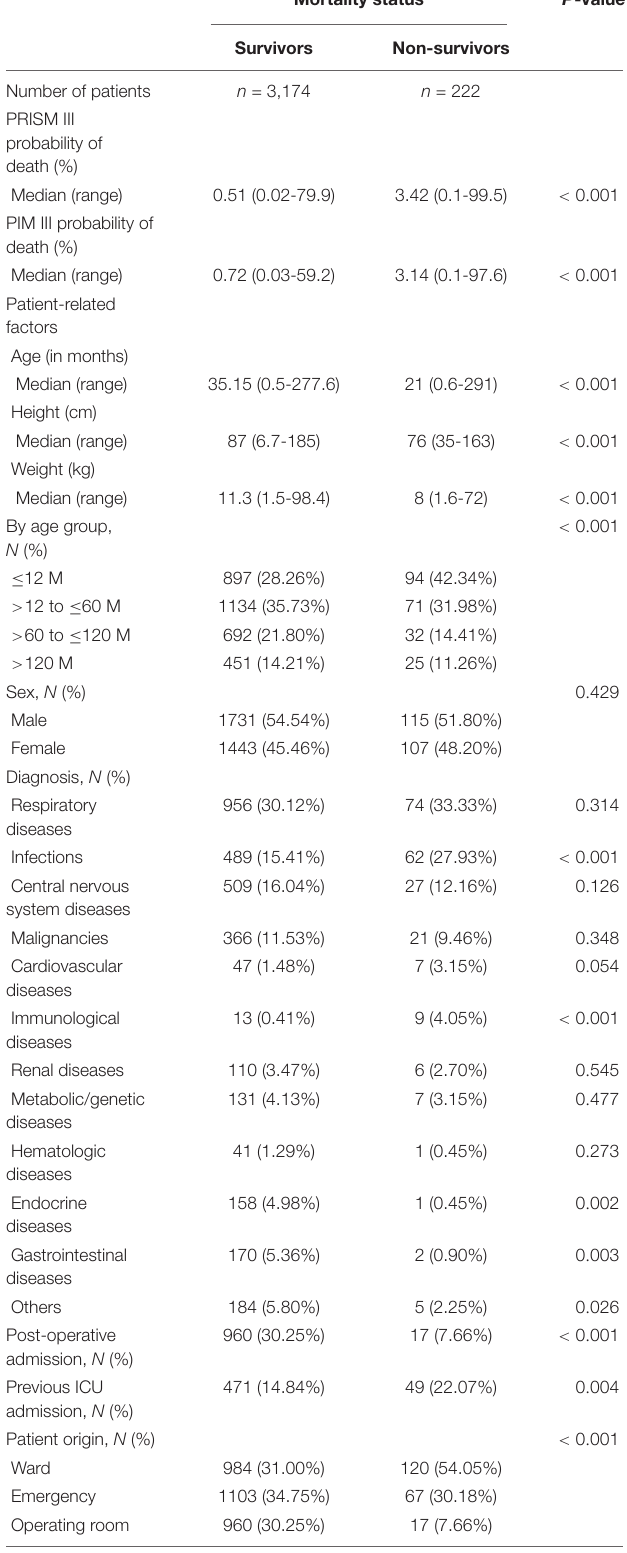
TABLE 1 | Characteristics of the study population according to